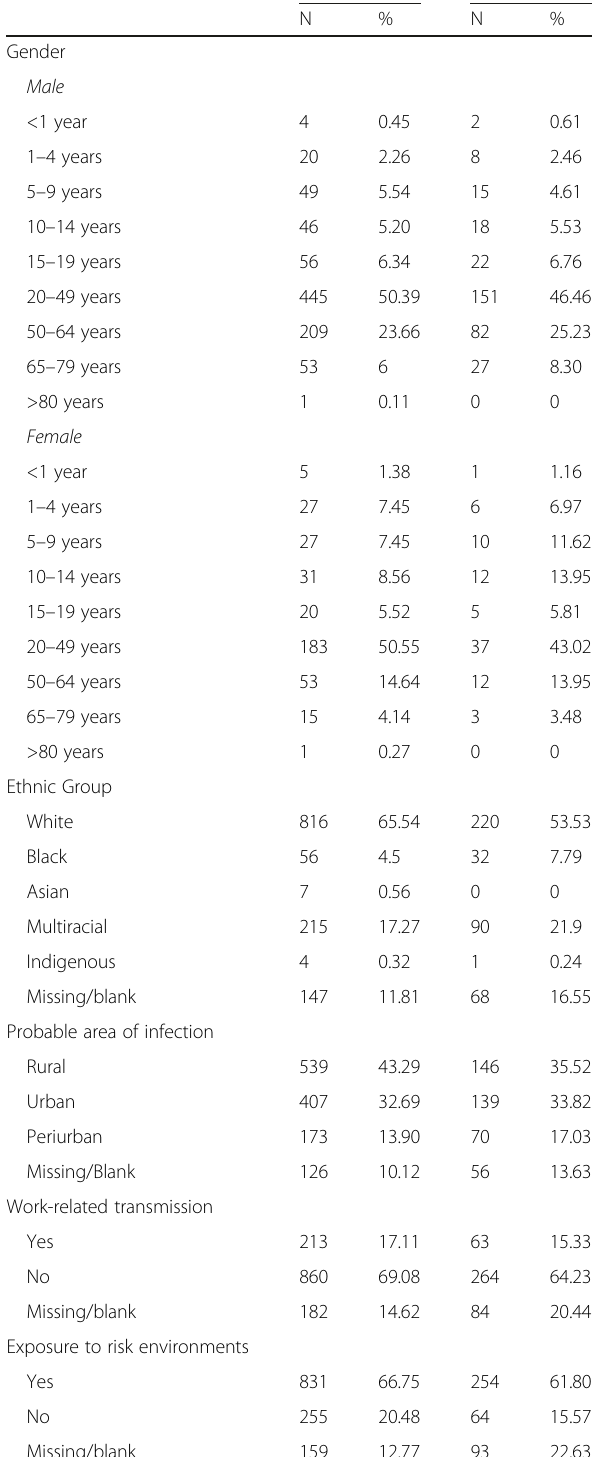
Table 1 Absolute number and percentage of confirmed spotted fever cases and deaths regarding probable area of infection, relation to work, exposure to risk environments and hospitalization, between 2007 and 2015 in Brazil